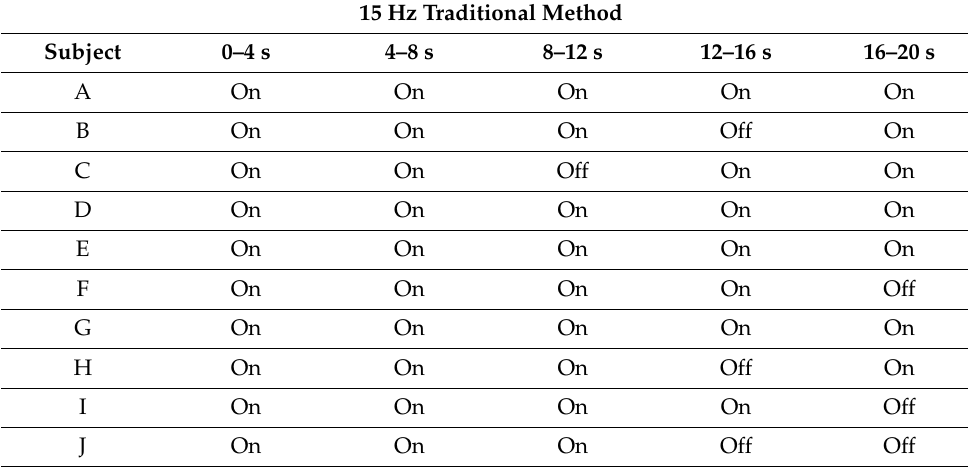
Table 1. The proposed method has five signals in the 15 Hz brainwave signal.